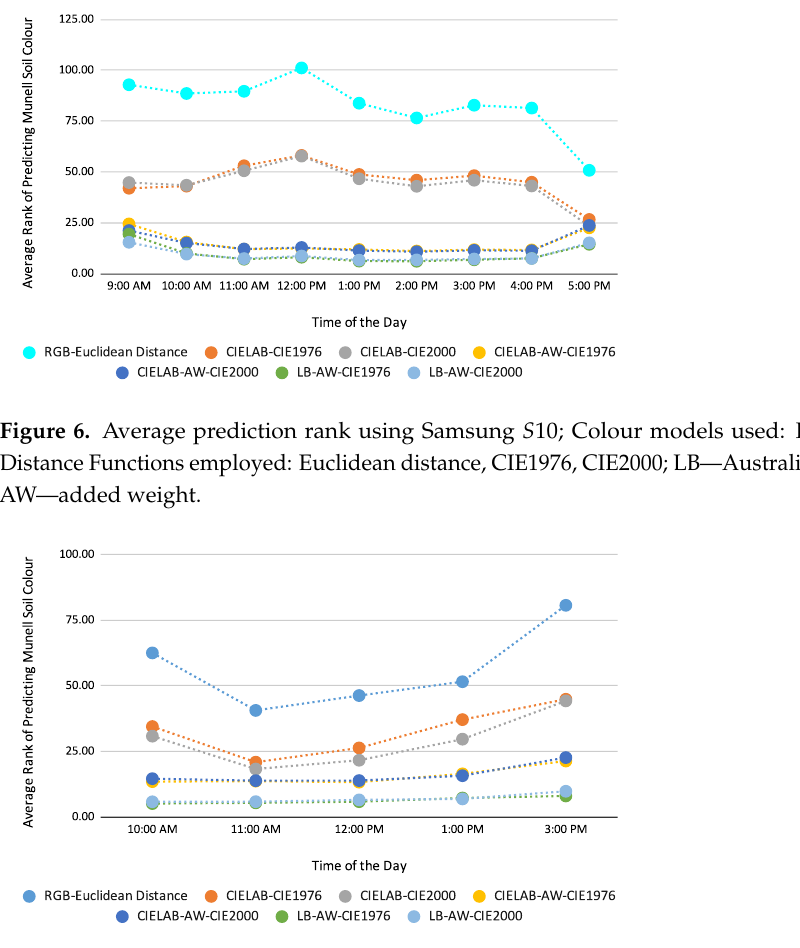
Figure 7. Average prediction rank using Google Pixel 5; Colour models used: RGB and CIELAB; Distance Functions employed: Euclidean distance, CIE1976, CIE2000; LB—Australian Location-Based, AW—added weight. Table 8. Summary of average prediction rank for both Samsung S 10 and Google Pixel 5 smartphones using CIELAB colour model and two distance functions (CIE1976 and CIE2000). Location-Based— Prediction using only prominent soil colours in Australian topsoils. AW—Proposed weight difference from Table